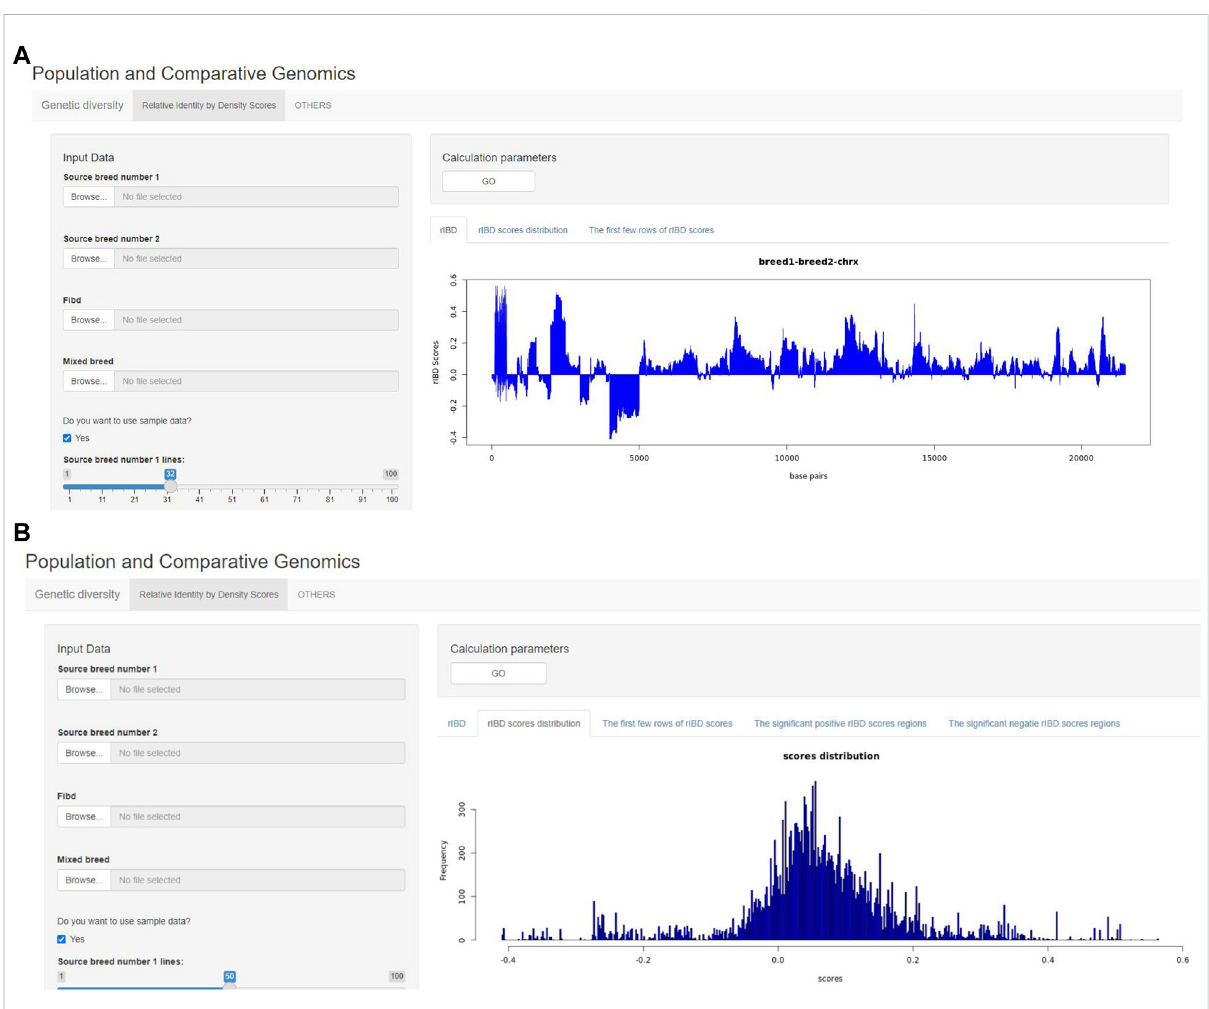
FIGURE 3 ThedemonstrationoftheoutputfromtherIBDcalculationplatform. (A) ThedemonstrationoftherIBDscoresfromthecalculationplatform; (B) The output rIBD distribution from the calculation